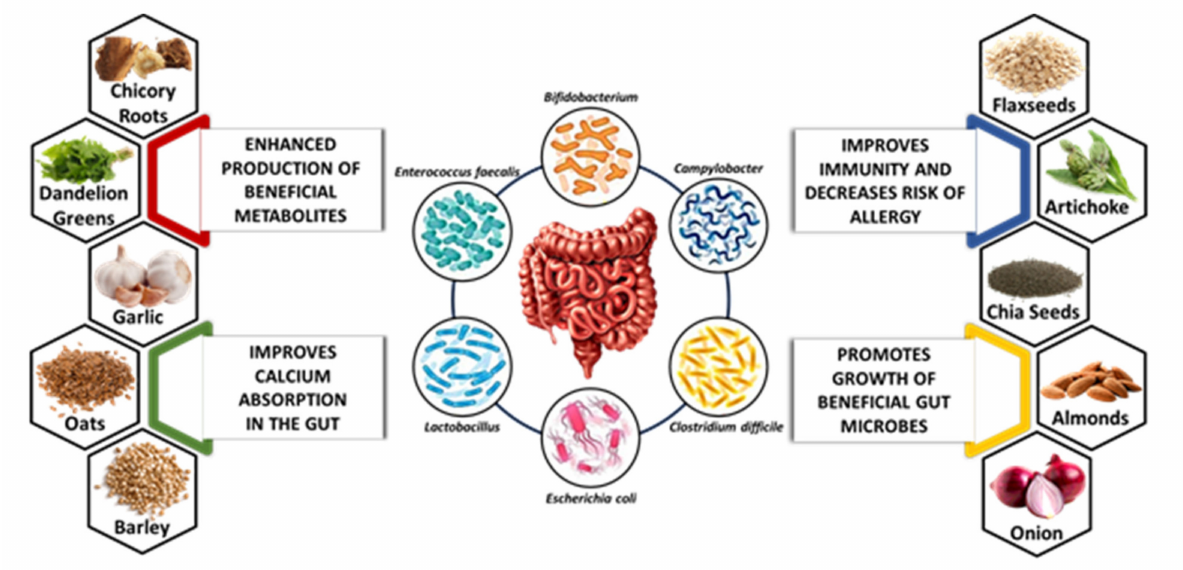
Figure 1. Diagrammatic illustration of sources and functions of